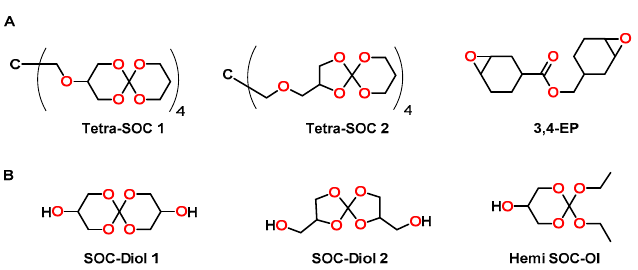
Figure 17. ( A ): Chemical structure of tetrafunctional SOCs and the cycloaliphatic epoxy monomer 3,4-EP. ( B ): Chemical structure of hydroxyl-modified SOC-Diol 1 and SOC-Diol 2 as well as Hemi SOC-Ol.